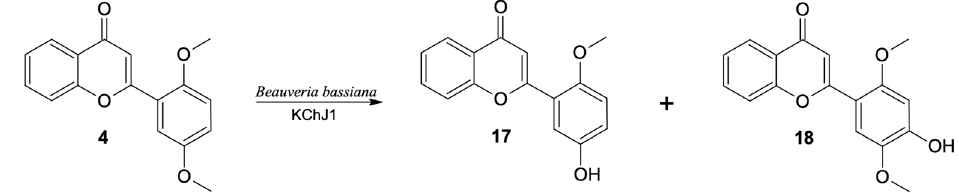
Figure 8. Biotransformation of 2 ′ ,5 ′ -dimethoxyflavone ( 4 ) in Beauveria bassiana KCh J1 culture.